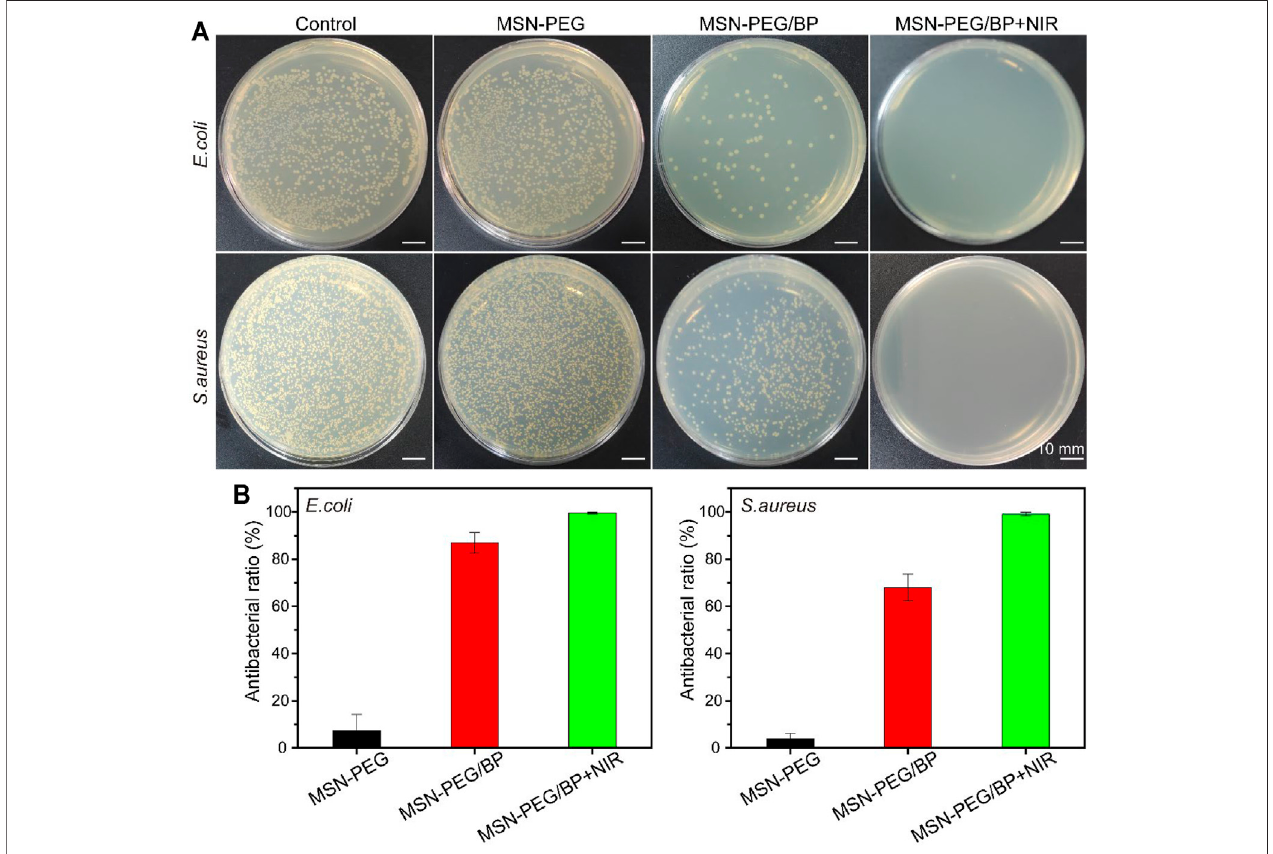
FIGURE2|(A) AgarPetridishimagesof E.coli and S.aureus bacterialcoloniesafterthetreatmentsand (B) theircorrespondingsurvivalrates invitro :(1)Control,(2) MSN-PEG, (3) MSN-PEG/BP, and (4) MSN-PEG/BP +